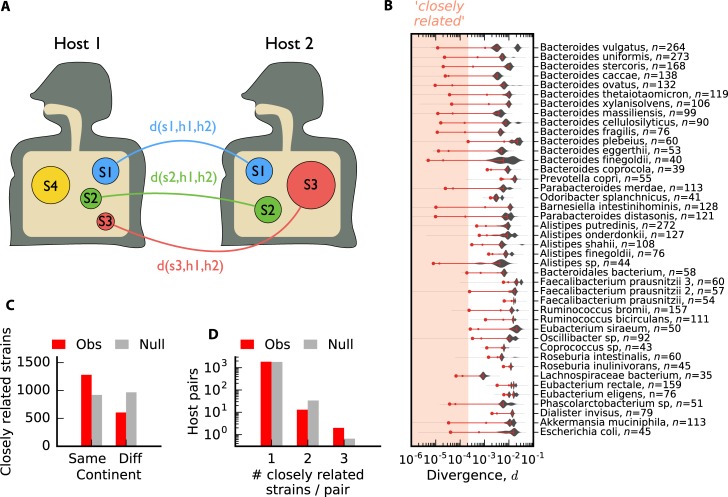
Between-host divergence across prevalent species of gut bacteria.(A) Schematic illustration. For a given pair of hosts (h1, h2), core-genome nucleotide divergence (d) is computed for each species (s1, s2, etc.) that is quasi-phaseable (QP) in both hosts. (B) Distribution of d across all pairs of unrelated hosts for a panel of prevalent species. Species are sorted according to their phylogenetic distances [33], with the number of QP hosts indicated in parentheses; species were only included if they had at least 33 QP hosts (>500 QP pairs). Symbols denote the median (dash), 1 percentile (small circle), and 0.1 percentile (large circle) of each distribution and are connected by a red line for visualization; for distributions with <103 data points, the 0.1 percentile is estimated by the second-lowest value. The shaded region denotes our ad hoc definition of "closely related" divergence, d≤2×10−4. (C) The distribution of the number of species with closely related strains in distinct hosts present in the same or different continents. The null distribution is obtained by randomly permuting hosts within each species. Although the observed values are significantly different than the null (P<10−4), the large contribution from different continents shows that closely related strains are not solely a product of geographic separation. (D) The distribution of the number of species with closely related strains for each pair of hosts. The null distribution is obtained by randomly permuting hosts independently within each species (n = 103 permutations, P≈0.9). This shows that there is no tendency for the same pairs of hosts to have more closely related strains than expected under the null distribution above.